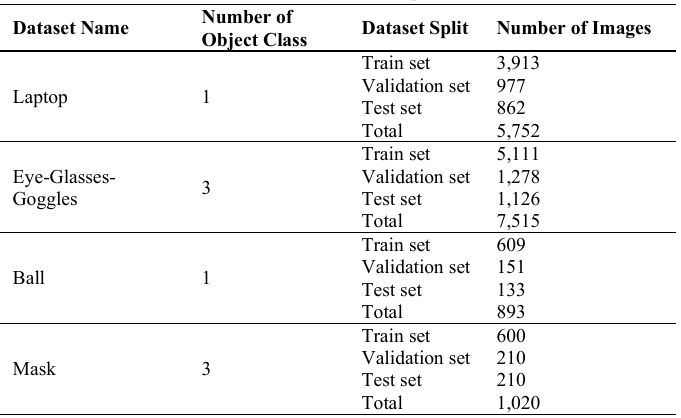
TABLE 2 E XPERIMENTAL D ATASET